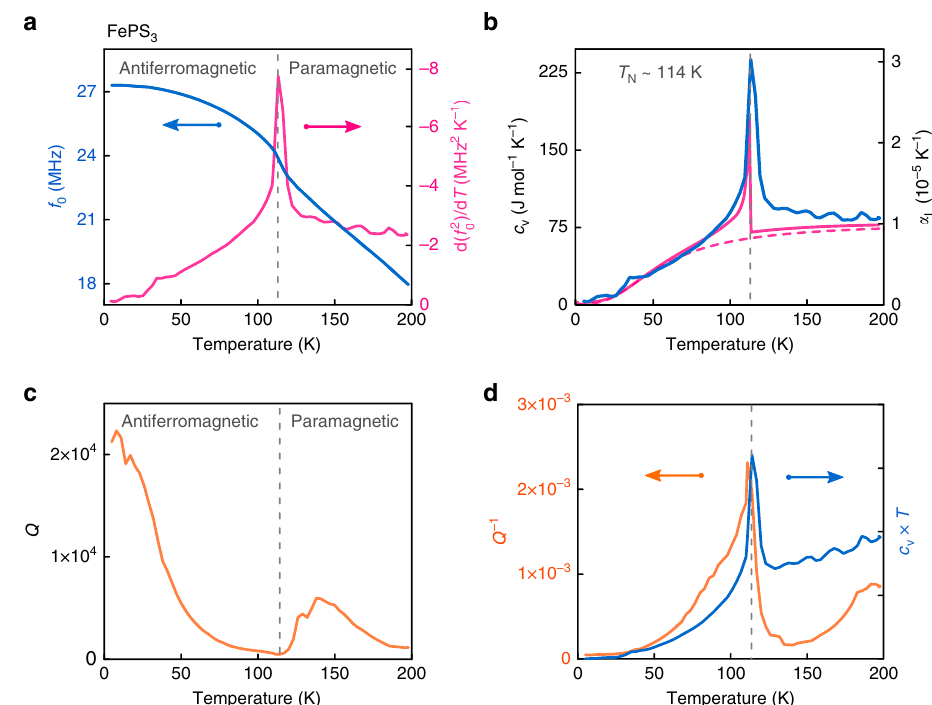
Fig. 2 Mechanical and thermal properties of a FePS 3 resonator with membrane thickness of 45.2± 0.6 nm. In all panels, dashed vertical lines indicate the detected transition temperature, T N = 114 ± 3 K as determined from the peak in the temperature derivative of f 2 resonance frequency as a function of temperature. Solid magenta line — temperature derivative of f 2 and corresponding thermal expansion coef fi cient. Solid magenta line — the theoretical calculation of the magnetic speci fi c heat as reported in Takano et al. 15 added to the phononic speci fi c heat from Debye model (dashed magenta line) with a Debye temperature of Θ D = 236 K 15 . c Mechanical quality factor Q ( T ) of the membrane fundamental resonance. d Solid orange line — measured mechanical damping Q − 1 ( T ) as a function temperature. Solid blue line — normalized c v ( T ) T term 20,21 (see Supplementary equation (14)), with c v ( T ) taken from ( b